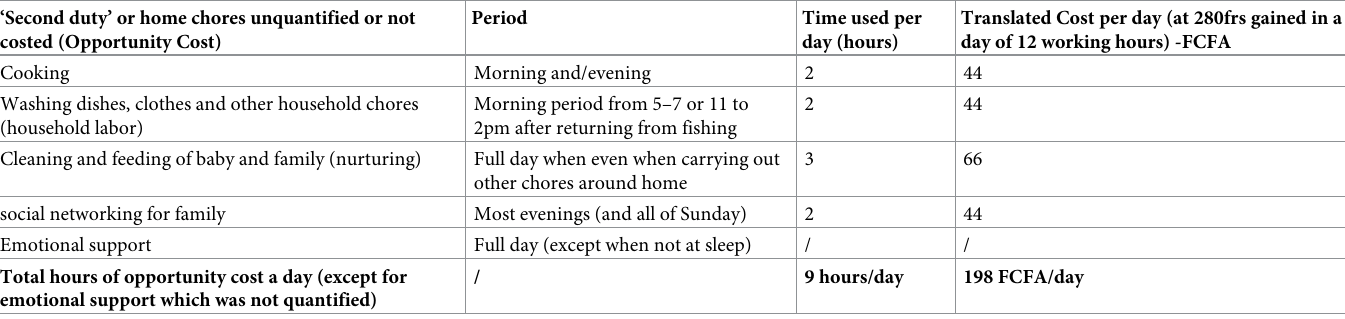
Table 8. Opportunity cost of